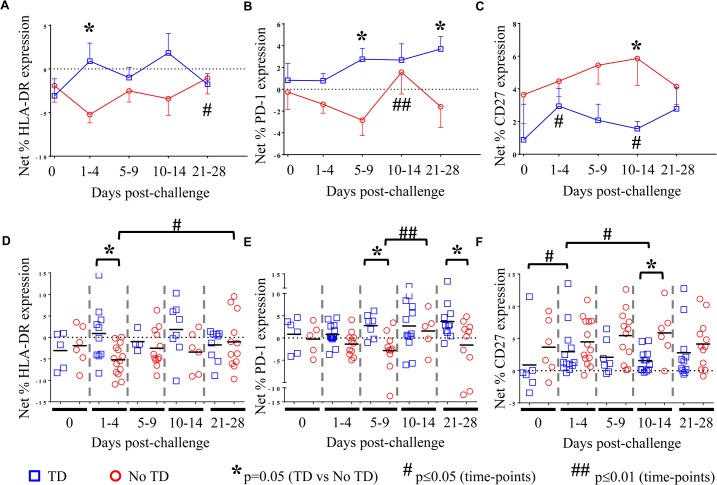

S. Typhi-specific activation of circulating Treg.Net S. Typhi-specific expression of A) HLA-DR, (TD n = 5, No TD n = 4) B) PD-1, (TD n = 6, No TD n = 6) and C) CD27, (TD n = 6, No TD n = 6) on Treg. Values are shown as the mean +/- SEM. Scatter plots showing the net expression of D) HLA-DR, (TD n = 5, No TD n = 4) E) PD-1, (TD n = 6, No TD n = 6) and F) CD27, (TD n = 6, No TD n = 6) on S. Typhi-specific Treg. Means are indicated with a black horizontal line. Time points with statistically significant differences between TD and No TD volunteers (*) or among time-points within each group (#) are identified. P-values were determined using a mixed effects regression model. TD (blue squares); No TD (red circles). Values from multiple time-points were grouped together in time segments (1–4, 5–9, 10–14, and 21–28 days post-challenge) to account for variability in the numbers of samples available from each volunteer. Some volunteers had samples from multiple time-points in a time-segment resulting in more data points than the corresponding number of volunteers.